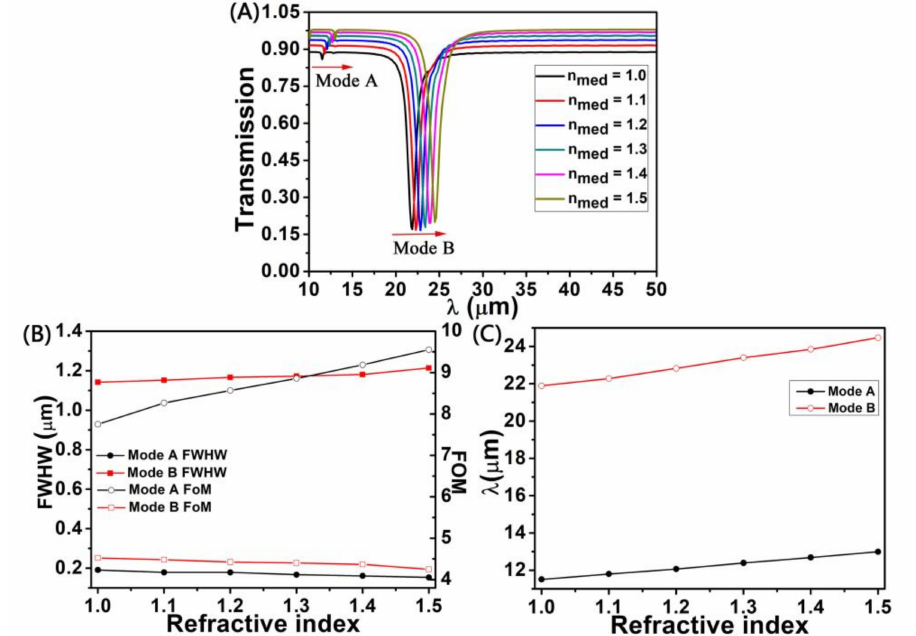
Figure 4. ( A ) The transmission spectra of graphene with different sensing medium refractive index ( n med ); ( B ) full width at half maximum (FWHM) and figure of merit (FOM) of mode A and mode B for different the n med ; ( C ) For mode A and mode B, the transmission dip wavelength corresponding to transmission dip as a function of the n med . Structural parameters: L = 180 nm; P = 300 nm; W 1 = W 2 = 30 nm; and n g = 3 × 10 13 cm − 2